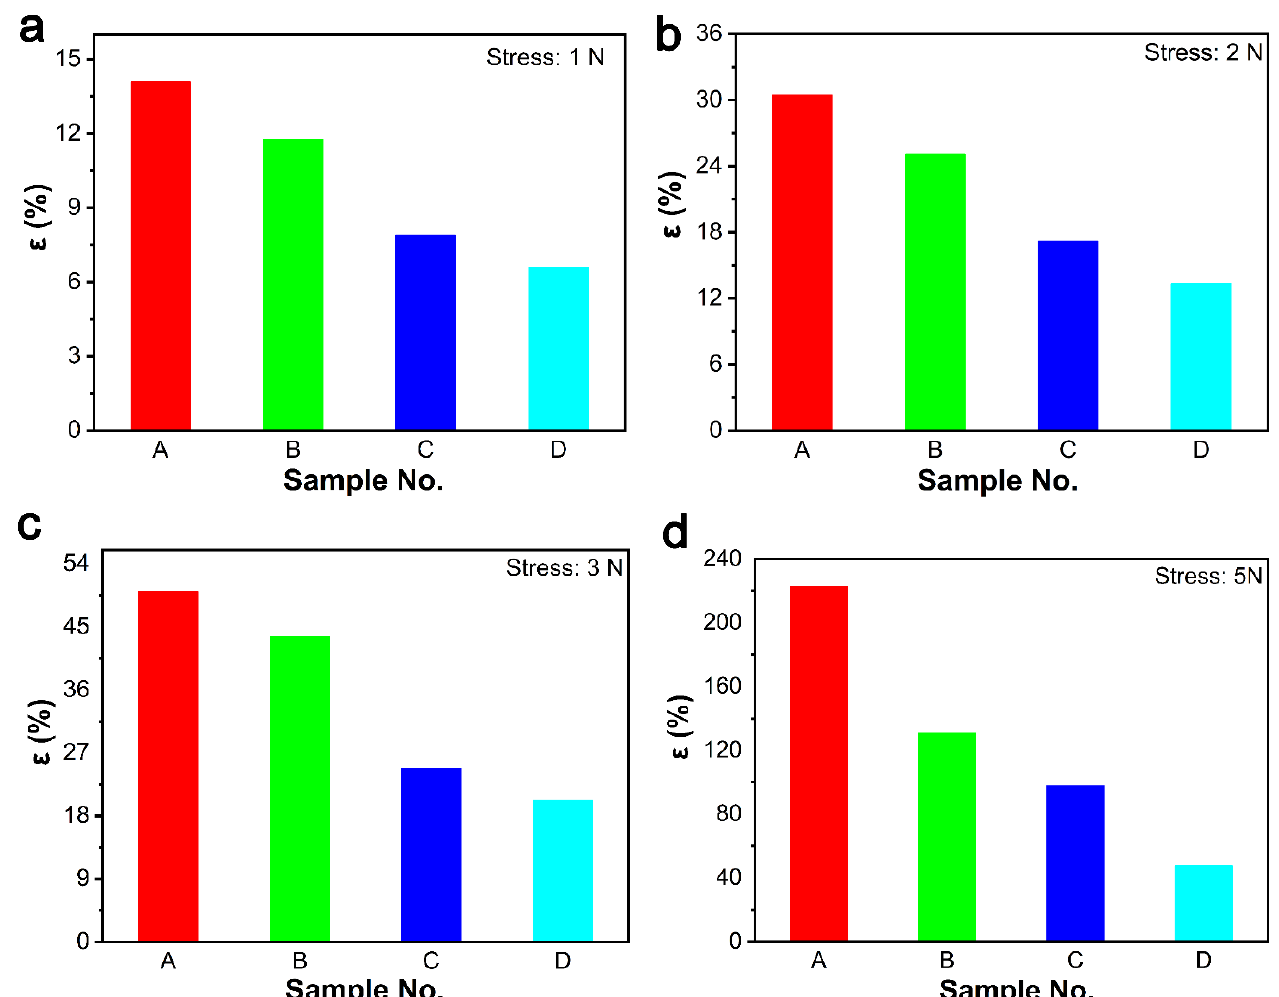
◦ C: ( a ) 1 N; ( b ) 2 N; ( c ) 3 N; and ( d ) 5